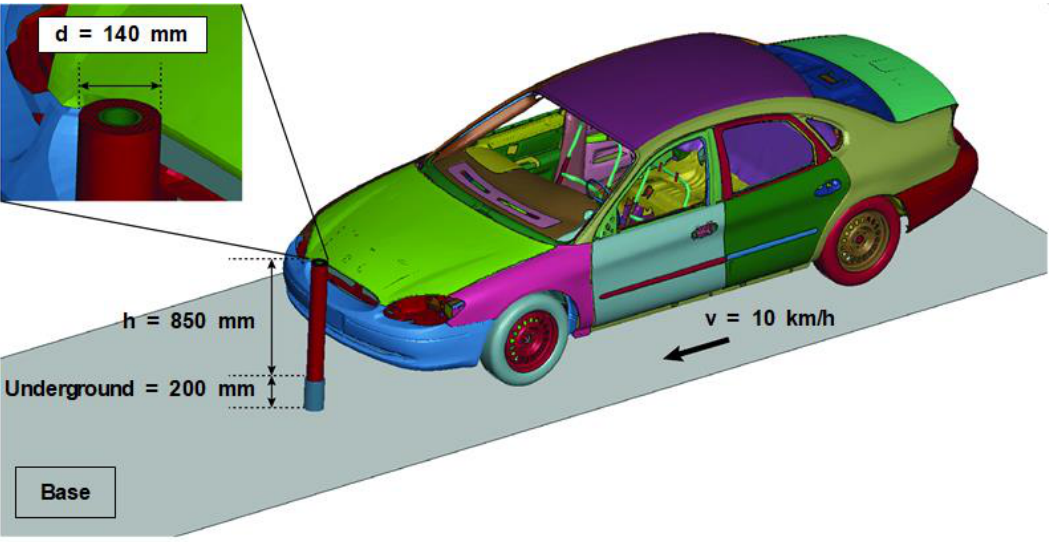
Figure 6. LS-DYNA simulation settings.